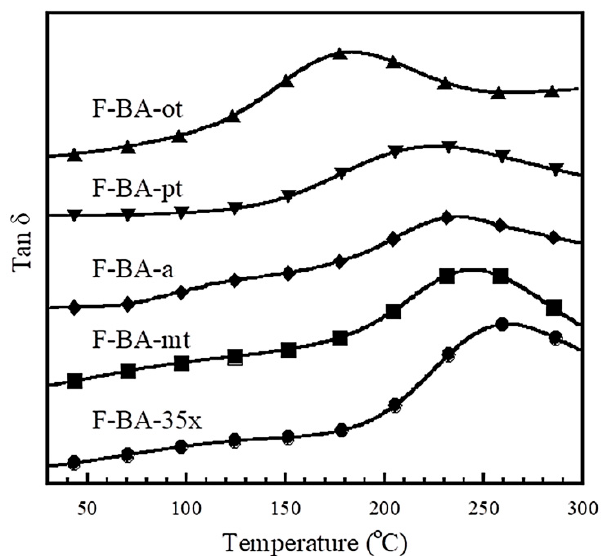
Figure 2. Loss tangent (Tan δ ) as a function of the temperature of polybenzoxazine composites